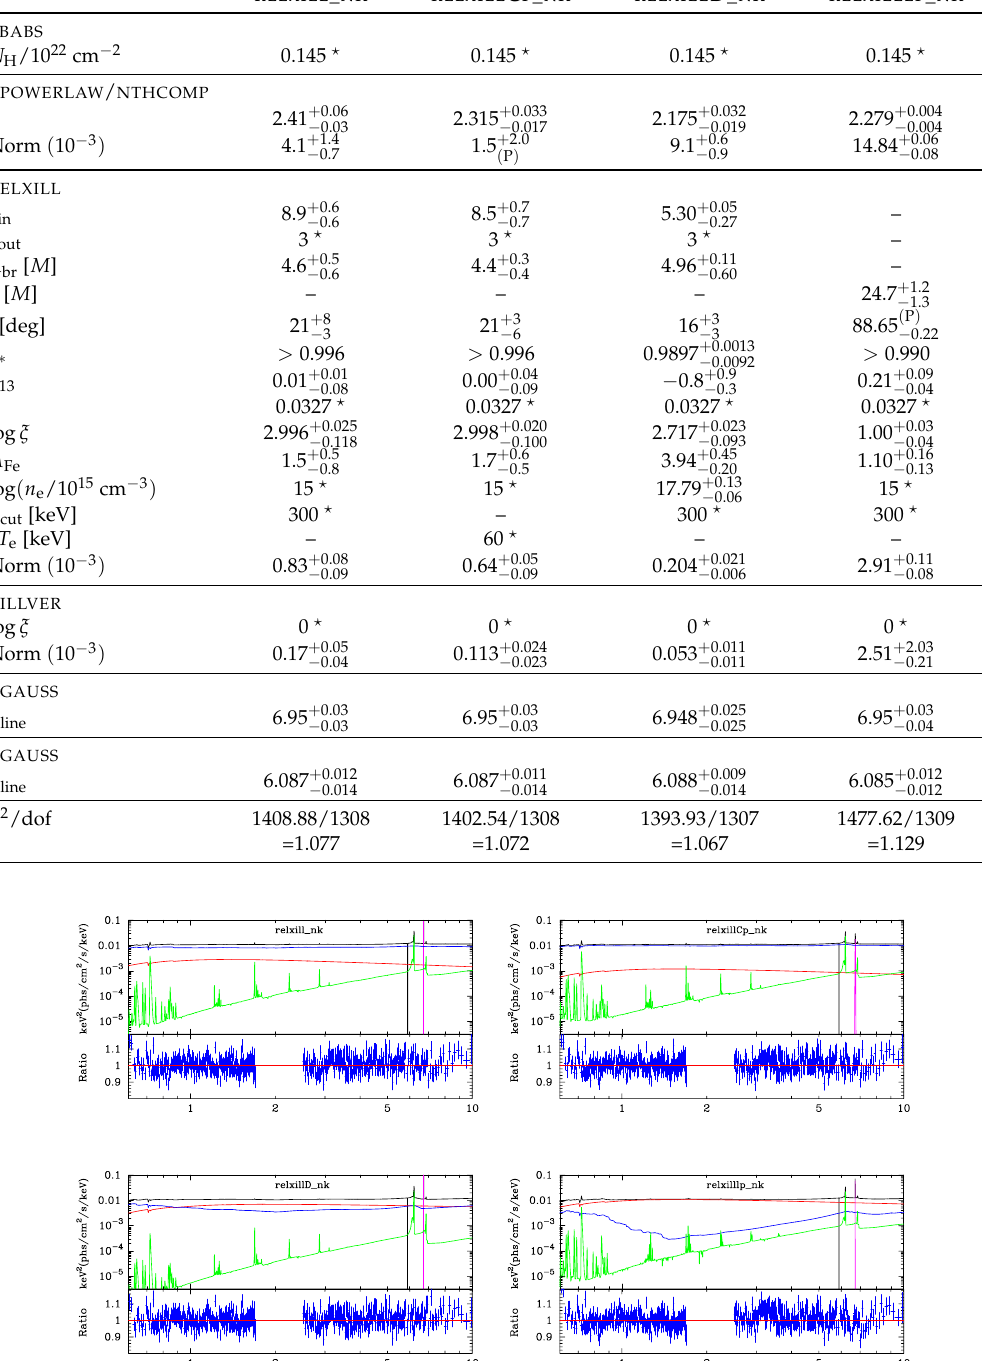
Figure A3. Spectra of the best fit models with the corresponding components ( upper panels ) and data to best-fit model ratios ( lower panels ) for Ark 120 when the reflection component is modeled by RELXILL _ NK ( top left panel ), RELXILL C P _ NK ( top right panel ), RELXILL D_ NK ( bottom left panel ), and RELXILLLP _ NK ( bottom right panel ). The total spectra are in black, power law components from the coronas are in red, the relativistic reflection components from the disk are in blue, the non-relativistic reflection components from cold material are in green, and the gaussian lines are in